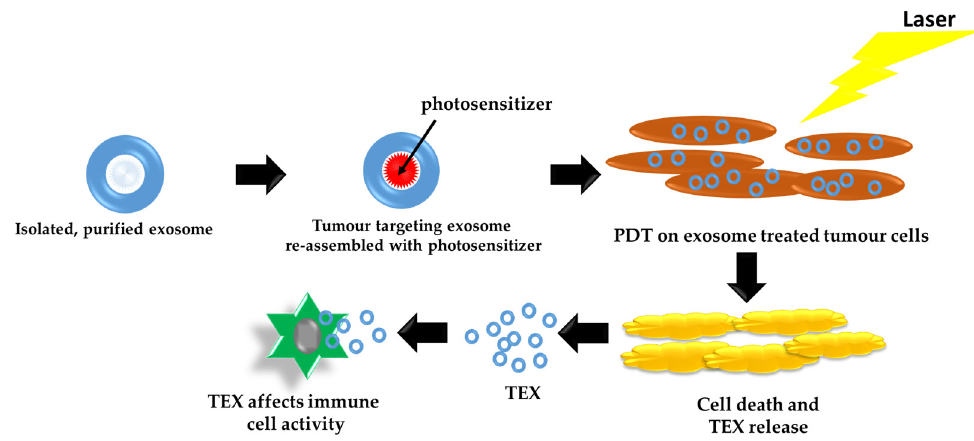
Figure 4. Re-assembled exosome as a drug delivery carrier loaded with a photosensitizer. TEX affects the activity of immune cells.